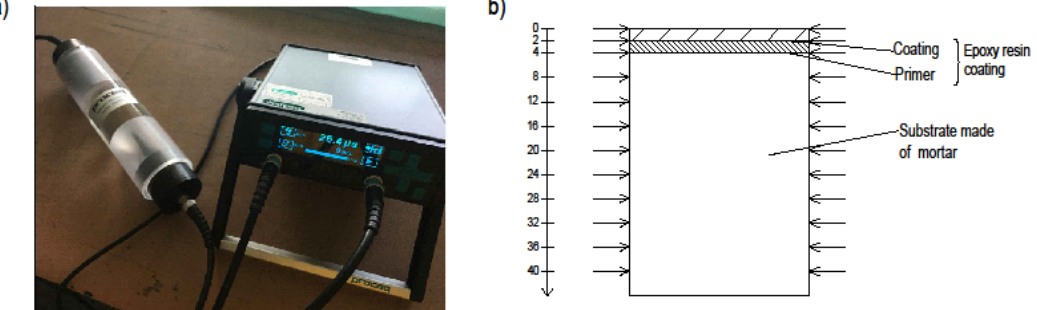
Figure 8. Ultrasonic testing: ( a ) device accuracy test, ( b ) diagram of measuring points on the sample’s